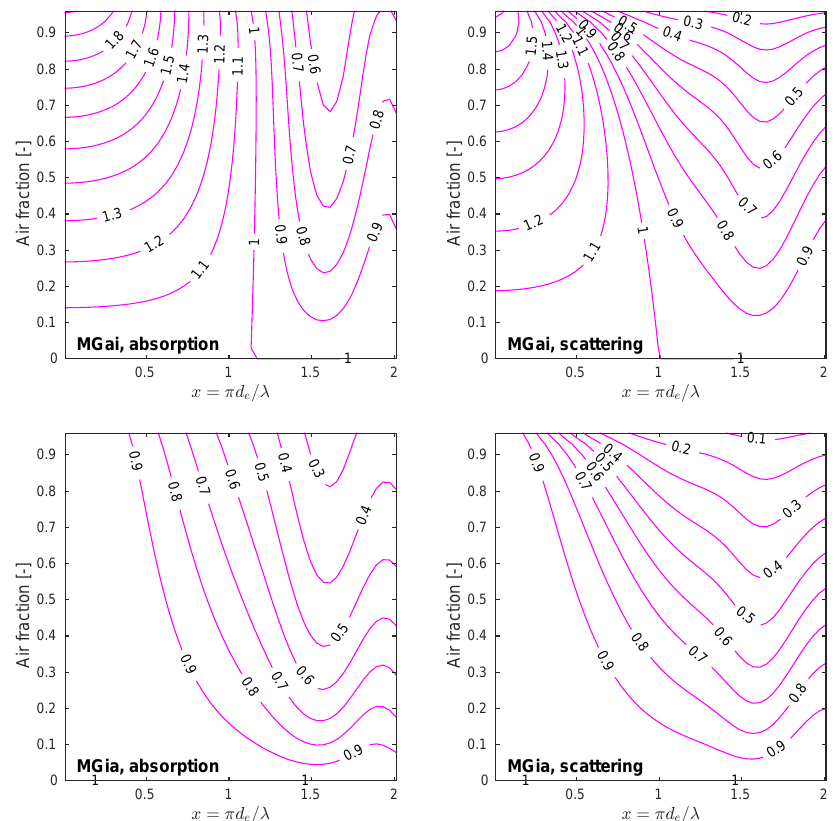
Figure 6. Absorption (left) and scattering (right) cross sections of soft spheres (183GHz and 243K), normalised by the equivalent mass ice sphere absorption or scattering cross section as in Fig. 4, as a function of size parameter and air fraction. The two top panels are calculated using the MG ai (air in ice) mixing rule, while the two lower panels are calculated using the MG ia (ice in air) mixing